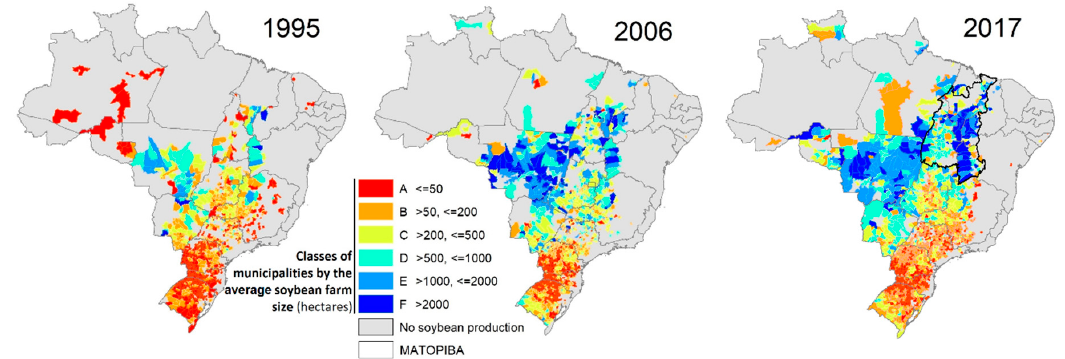
Figure 2. Spatiotemporal changes in the average size of soybean farm size across Brazilian municipalities, in 1995, 2006, and 2017. The blue shade represents municipalities of large soybean farm size (mean values).